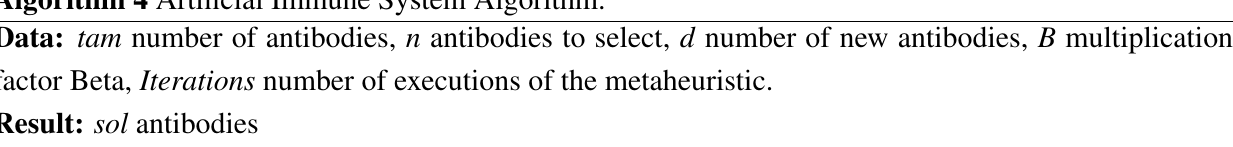
Algorithm 4 Artificial Immune System